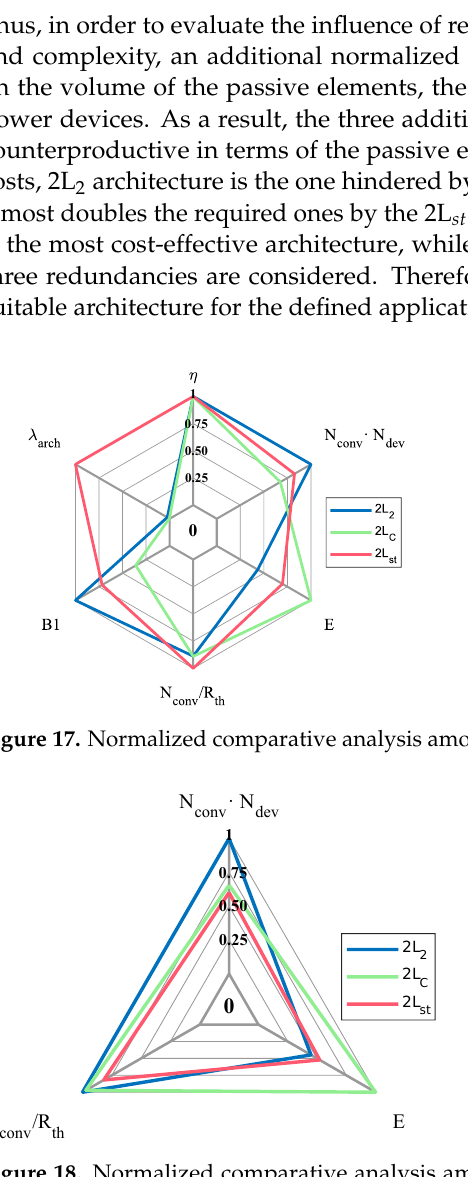
Figure 18. Normalized comparative analysis among 2L 2 , 2L C , and 2L st architectures when three redundancies are